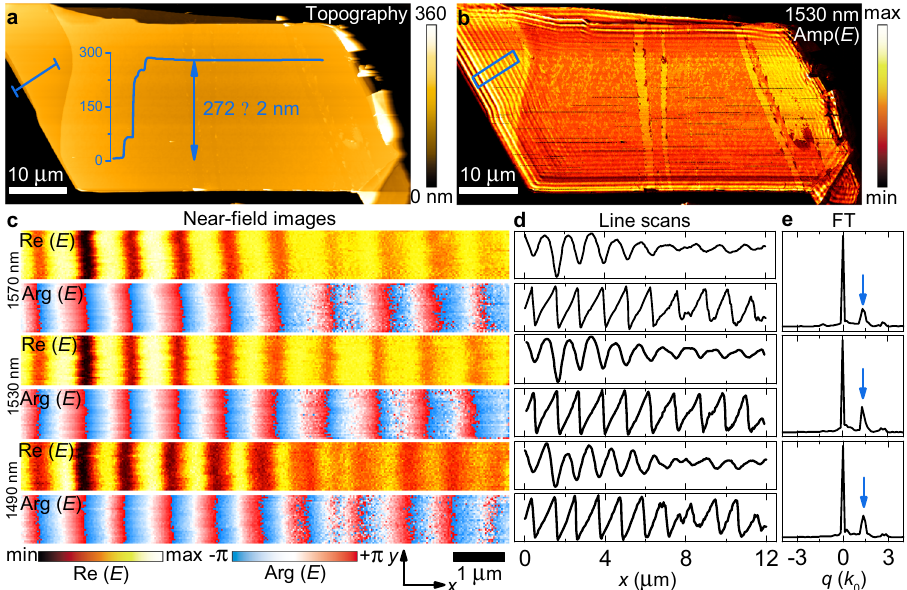
Fig. 3 Waveguide modes imaged by s-SNOM. a Topography image of the analyzed MoS 2 fl ake. A pro fi le taken from the region labeled by blue line is shown. b Near- fi eld amplitude image of the fl ake recorded at λ = 1530 nm. The region with the strongest signal is framed by a blue rectangular. c Near- fi eld images, real part Re(E) and phase Arg(E), of the electric fi eld E taken at 1570nm (top), 1530nm (middle), and 1490nm (bottom) in the area of the image in b , indicated by a blue rectangle. d x -line scans taken from c and averaged over 1.2 μ m along the y -axis (other wavelength images are collected in Supplementary Note 5). e Fourier transform (FT) amplitude of the complex near fi eld signal in d . Blue arrows mark the peak associated with the waveguide mode.